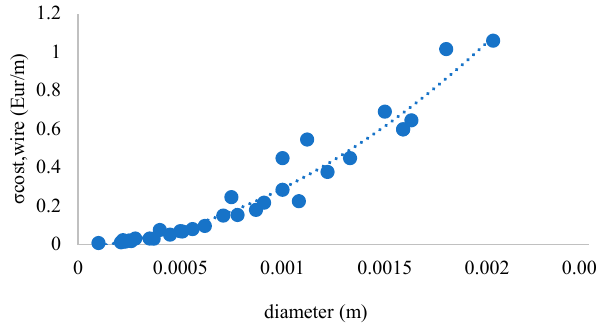
Figure 16. The fitting of plain copper wire cost per meter.